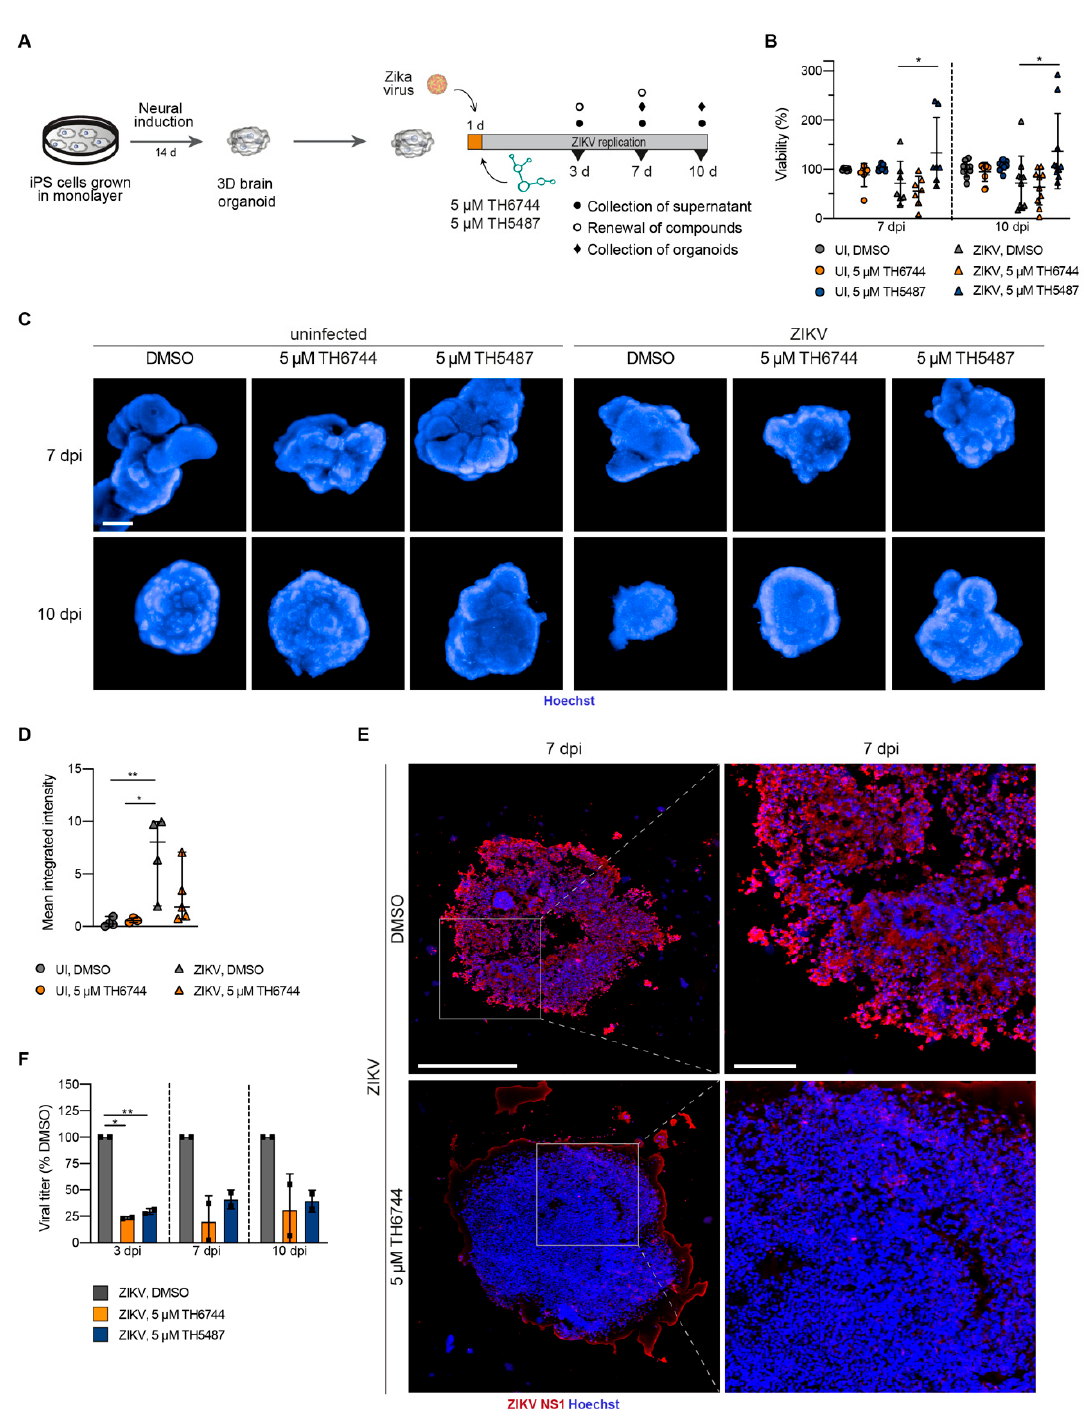
Figure 3. TH6744 and TH5487 treatment reverses ZIKV-induced neurotoxicity and limits ZIKV propagation in three-dimensional (3D) cerebral organoids. ( A ) Experimental workflow of ZIKV infection on brain organoid model. ( B – F ) Organoids were infected with ZIKV (2 × 10 4 particles/organoid) followed by treatment with 5 µ M TH6744, 5 µ M TH5487 or DMSO. ( B ) Organoids were dissociated to single cells at 7 or 10 dpi and cell viability was measured by Resazurin assay. Viability is shown relative to uninfected DMSO-treated control at respective timepoints. One datapoint represents one organoid. Data are presented as a mean ± SD of n = 2 biological replicates. Statistical significance was determined using two-way ANOVA with Dunnett’s multiple comparison analysis. * p < 0.05, ** p < 0.01, ( C ) ZIKV-infected and uninfected whole organoids treated with TH6744 or DMSO for 7 or 10 dpi, stained by Hoechst and imaged by high-content confocal microscopy. Representative images of n = 2 biological replicates per condition. The scale bar equals 500 μ m. Hoechst in blue. ( D ) ZIKV-infected organoids that were treated with TH6744 or DMSO were fixed at 7 dpi, cryosectioned and stained